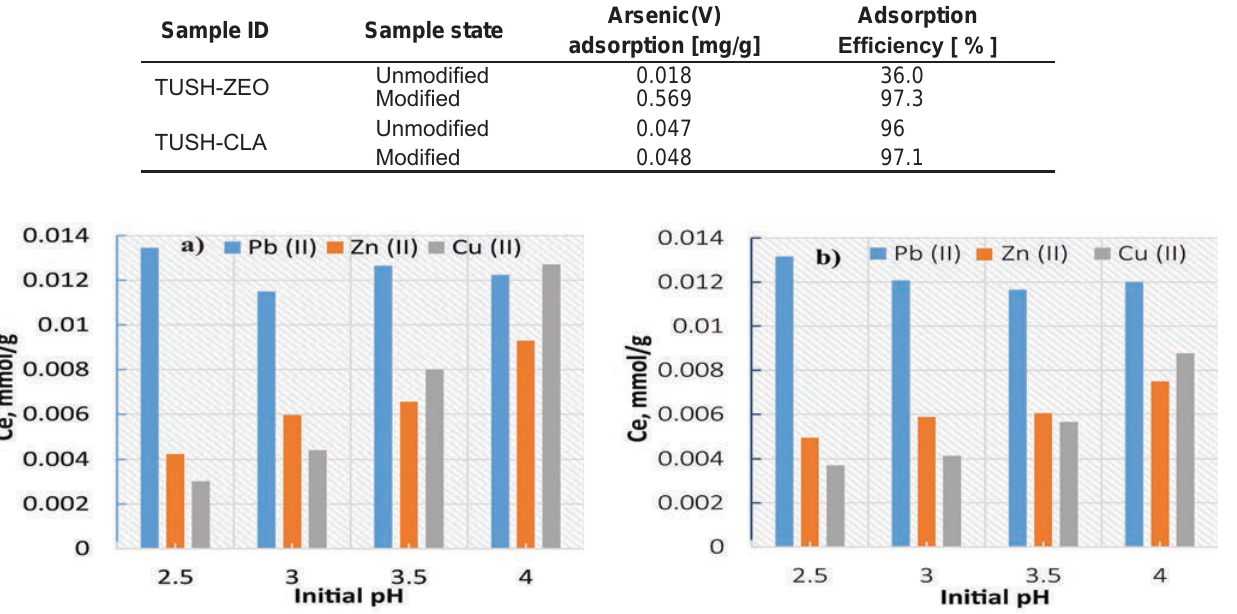
Fig. 6. Adsorption isotherms of heavy metals with a) TS.TS-ZEO and b) TUSH-ZEO